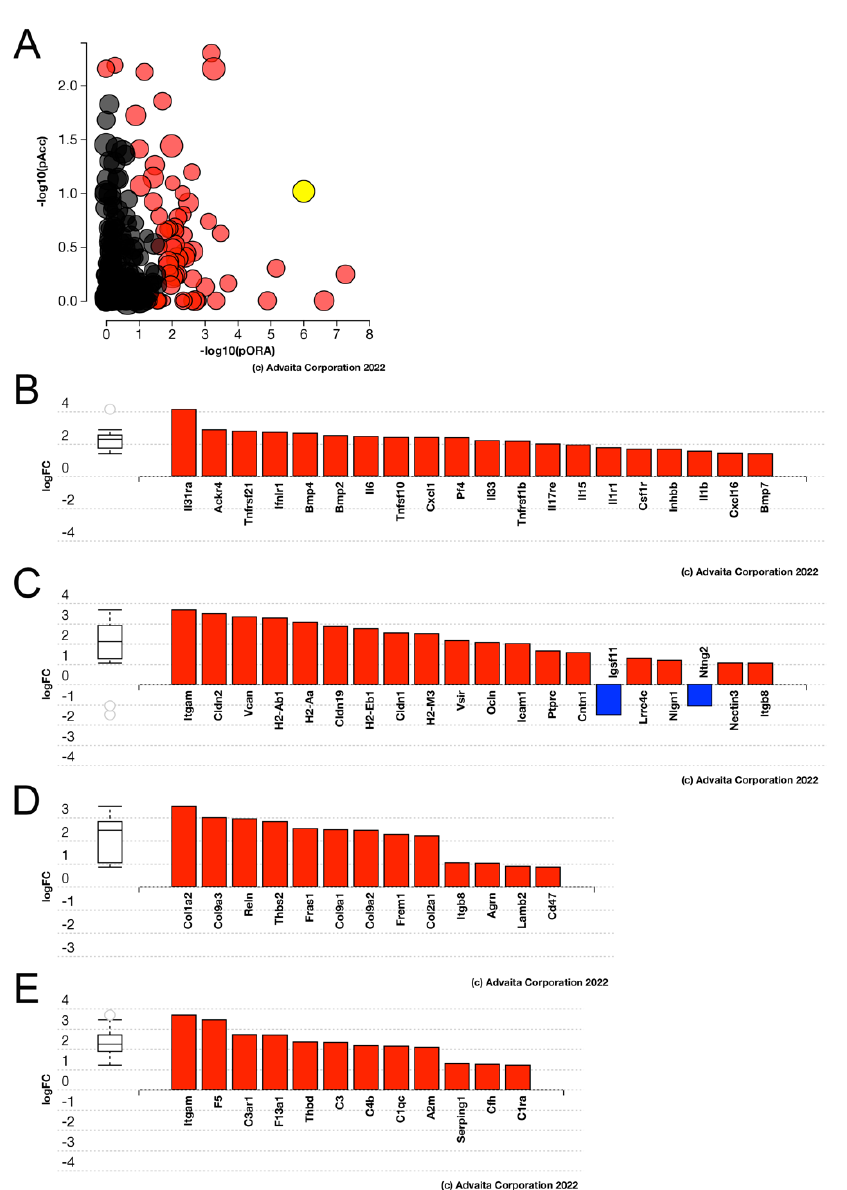
Figure 11. Advaita iPathway analysis of differentially expressed pathways/genes between 6 h FosBcKO and 6 h WT LECs. ( A ) Impact analysis of the DEGs suggest that the KEGG pathway map “cytokine - cytokine receptor interaction” ( p -value = 1.655 × 10 −6 ) (yellow dot) is the most significantly impacted pathway in the 6 h LECs. Other impacted KEGG pathways are represented by the other dots with black dots being non-significant KEGG pathways and red dots being significant KEGG pathways. ( B ) Bar graph showing the cytokine-cytokine receptor interaction genes that are differentially expressed in the 6 h FosBcKO LECs. ( C ) Bar graph showing the cell adhesion molecules ( p -value = 7.754 × 10 −6 ) pathway of genes differentially expressed in the 6 h FosBcKO LECs. ( D ) Bar graph showing the ECM-receptor interaction ( p -value = 4.252 × 10 −5 ) pathway of genes differentially expressed in the 6 h FosBcKO LECs. ( E ) Bar graph showing the complement and coagulation cascades ( p -value = 4.528 × 10 −5 ) pathway of genes differentially expressed in the 6 h FosBcKO LECs.